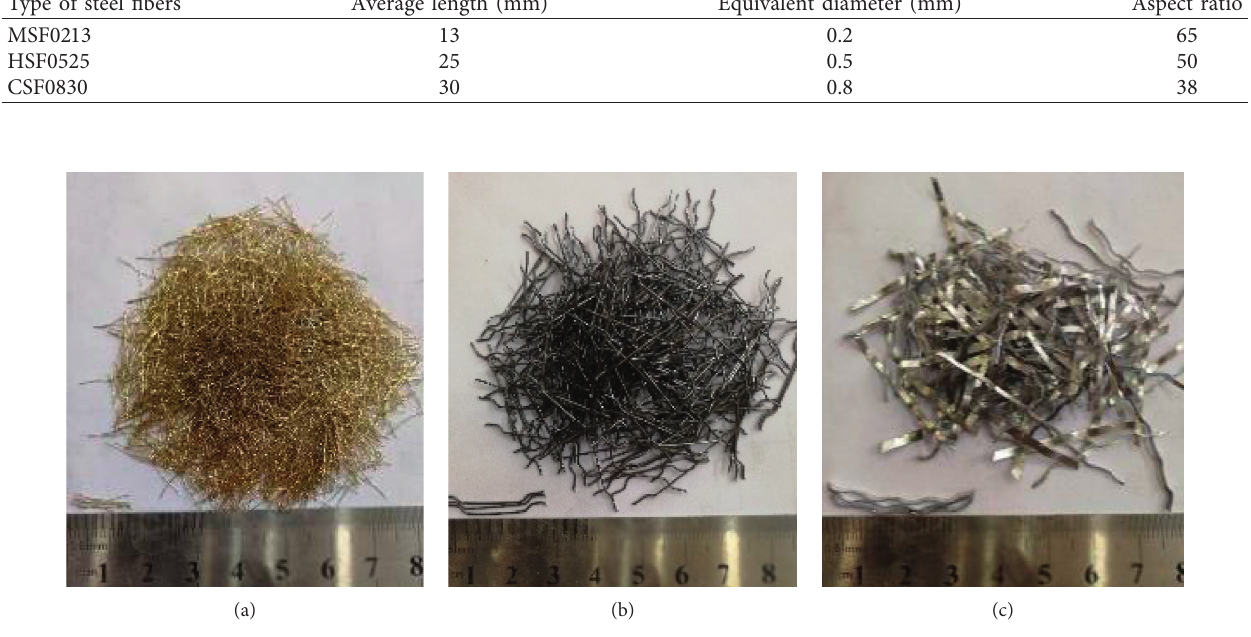
Figure 2: The appearance of steel fibers. (a) MSF0213. (b) HSF0525. (c) CSF0830. Table 3: Mix proportion of benchmark HLAC (kg/m 3 ).